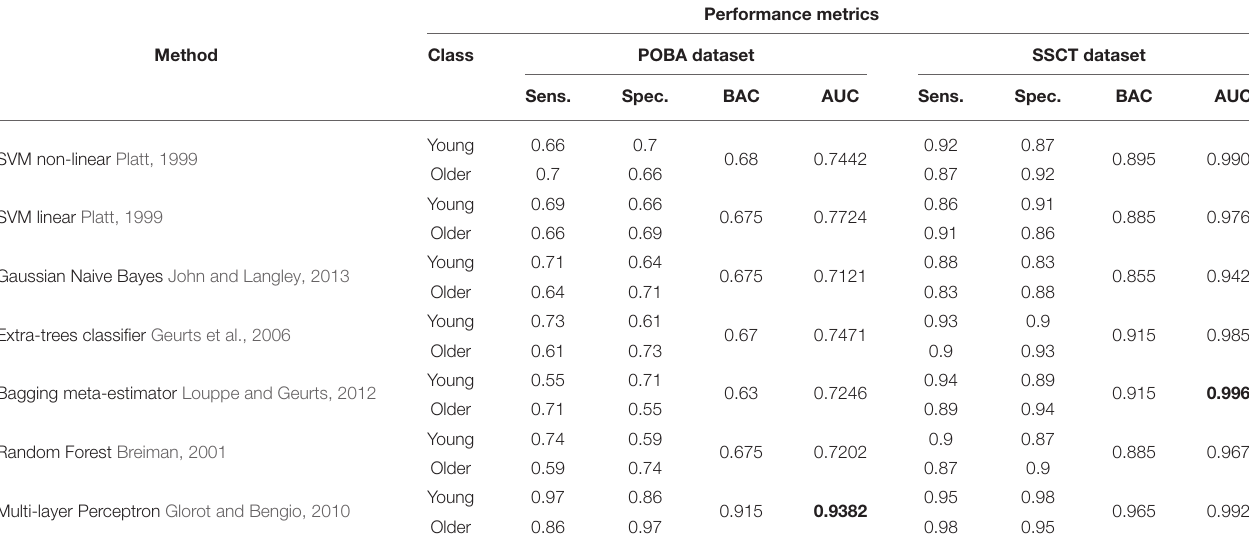
TABLE 8 | Performance of the machine learning classification models for the psychophysiological outcomes of brain atrophy and Stroop switching card test datasets assessed by sensitivity, specificity, and area under the curve